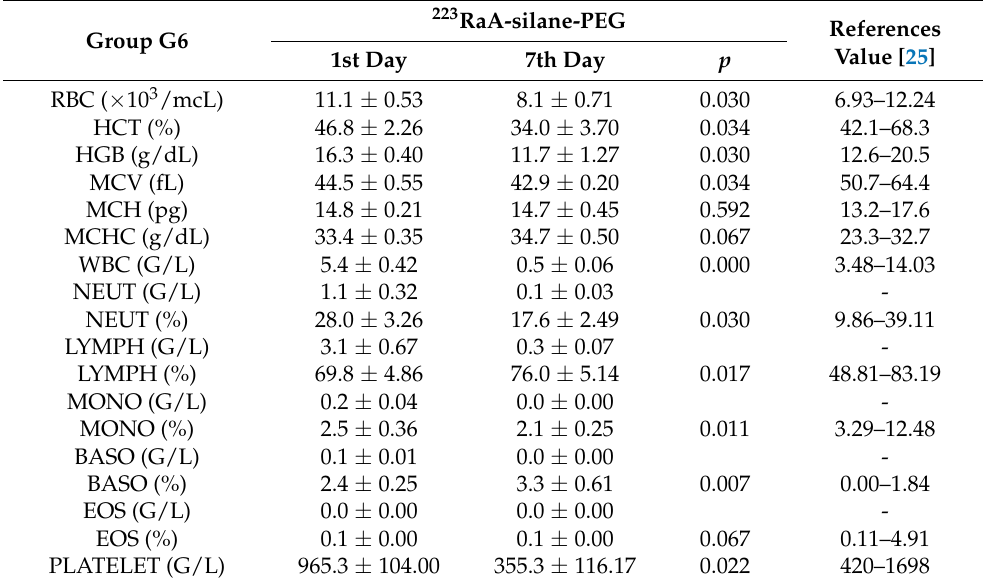
Table A5. Hematological parameters of blood of BALB/c mice at 1 and 7 days after injection with 223 RaA-silane-PEG.